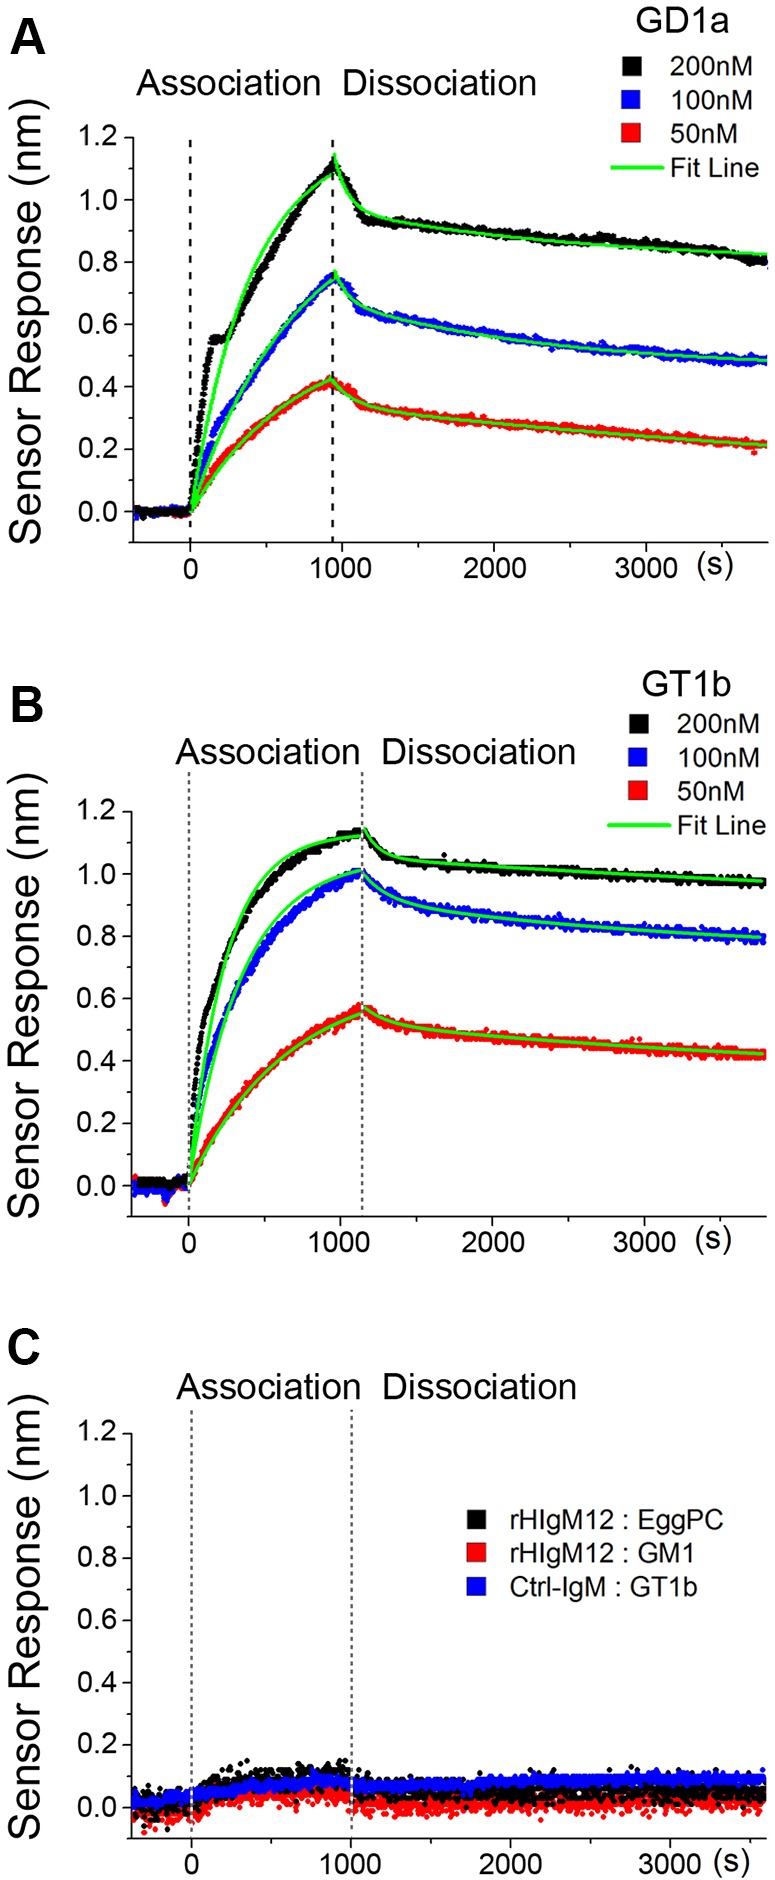
rHIgM12 binds with high affinity to GD1a and GT1b presented in supported lipid bilayers. Surface plasmon resonance was used to determine the association/dissociation curves of rHIgM12 binding to 5 mol% GD1a (A) and GT1b (B) in a lipid bilayer. The KD,apparent was 42.3±20.6 nM and 24.8±7.9 nM, respectively, for GD1a and GT1b (mean±s.e.m., n=4 and 6, collected over 2 and 3 days). (C) Control curves indicated that 100 nM rHIgM12 did not bind to lipid bilayers consisting of only egg PC, or to 5 mol% GM1 presented in a lipid bilayer. In addition, 100 nM of a control human IgM did not bind to GT1b presented in lipid bilayers.